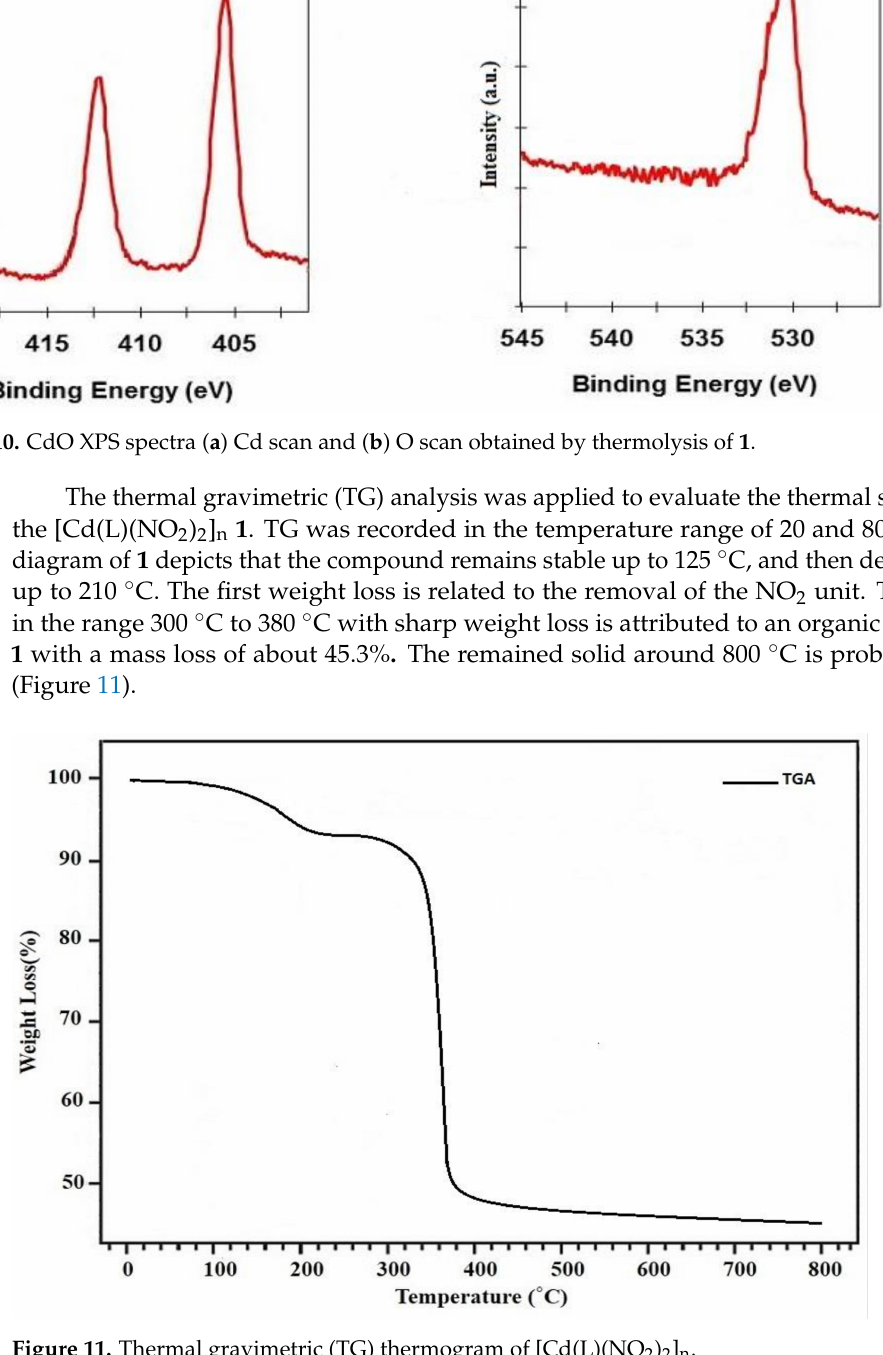
Figure 11. Thermal gravimetric (TG) thermogram of [Cd(L)(NO 2 ) 2 ] n